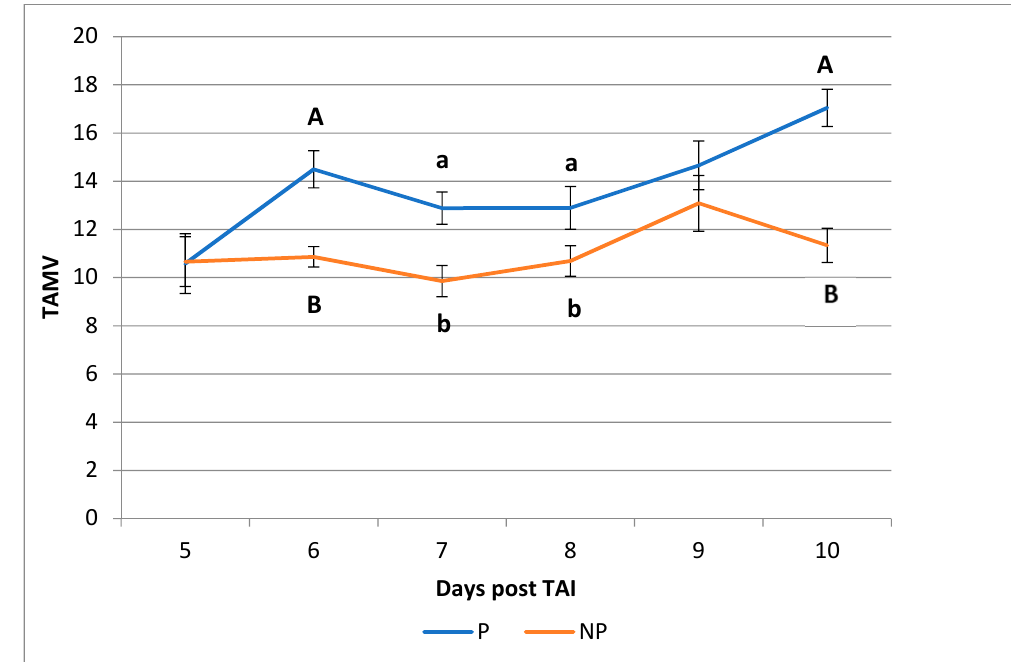
Figure 2. Time average medium velocity (TAMV) values recorded in pregnant (P) and nonpregnant (NP) buffaloes from Day 5 to Day 10 post-timed artificial insemination (TAI). A, B Values with different superscripts are significantly different; p < 0.01; a, b Values with different superscripts are significantly different; p < 0.05.